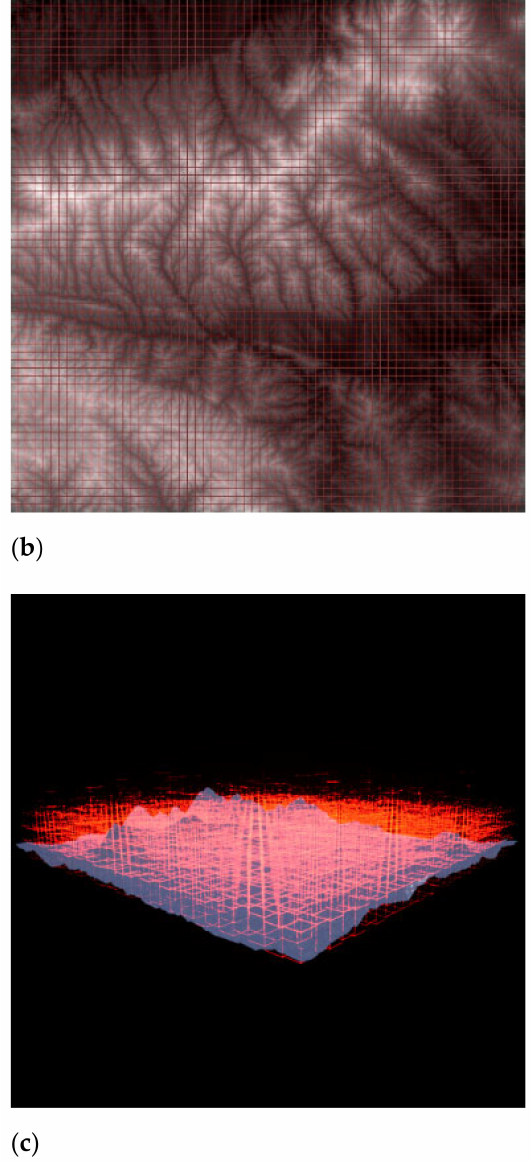
Figure 2. Diagram of the terrain and partitions. ( a ) represents the terrain height map, a 4096 × 4096 TIFF 32-bit, sampled at 12.5 m spacing, grayscale image. ( b ) represents the partition result, partitioned into 64 × 64 patches. ( c ) shows the scene’s partition, in addition to 32 × 32 partitions on the plane; it is partitioned in the vertical